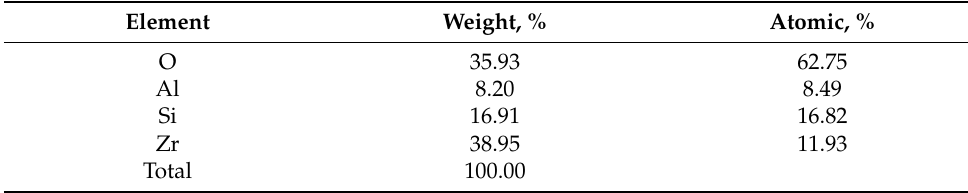
Table 3. Elemental proportions in point 3 of the sample #4.